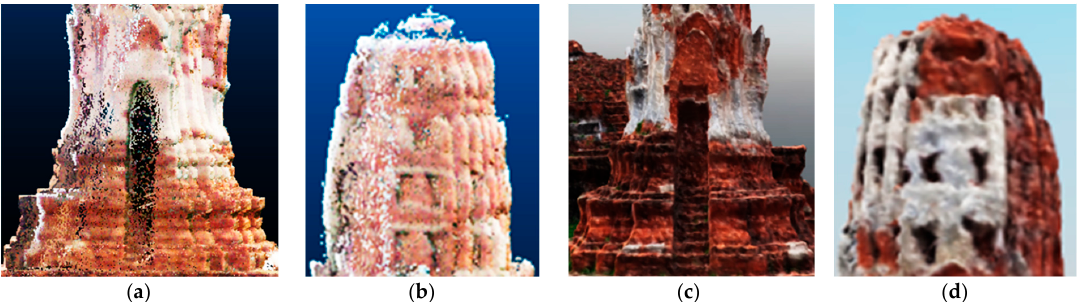
Figure 10. Comparison of the terrestrial and UAVs point cloud of the Prang structure: ( a ) Base of the Prang from TLS. ( b ) Top of the Prang from TLS. ( c ) Base of the Prang from UAV. ( d ) Top of the Prang from UAV.